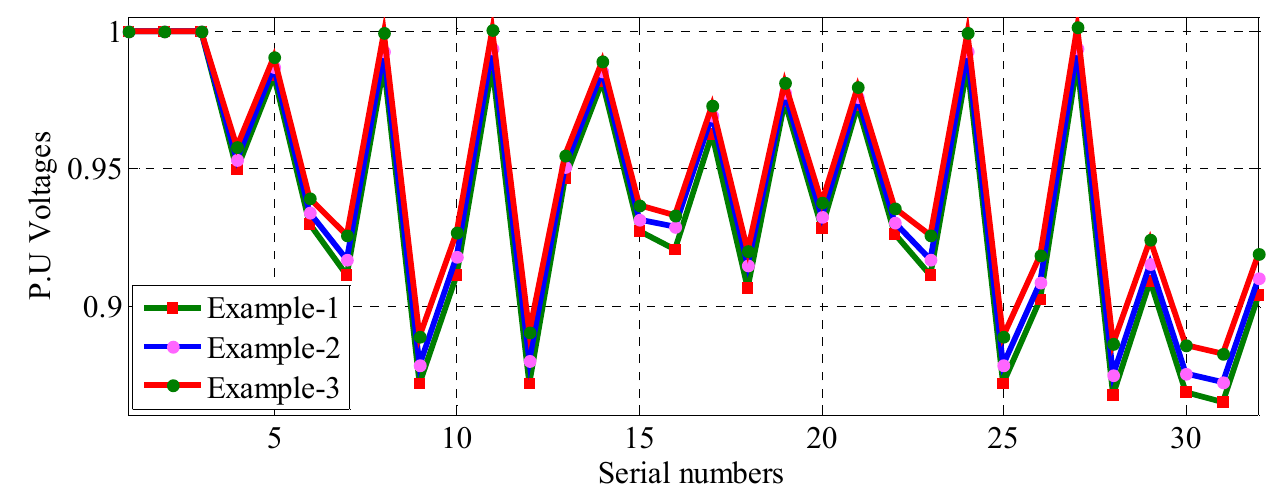
Figure 8. Comparison of voltage profiles for different study examples of the IEEE-13 bus URDN. Table 9. Study examples of the IEEE-34 bus URDN.